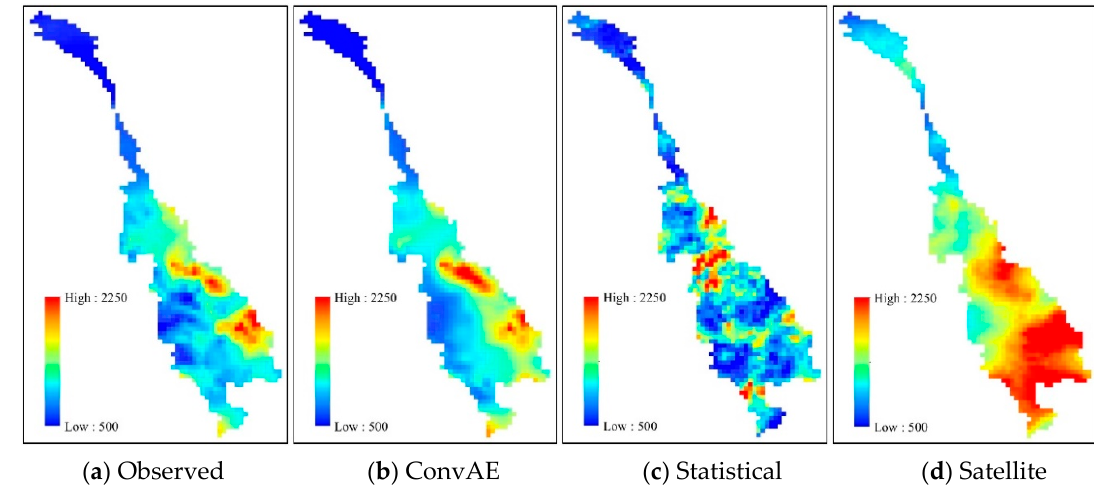
Figure 12. Spatial distribution pattern of the precipitation products in 2014.